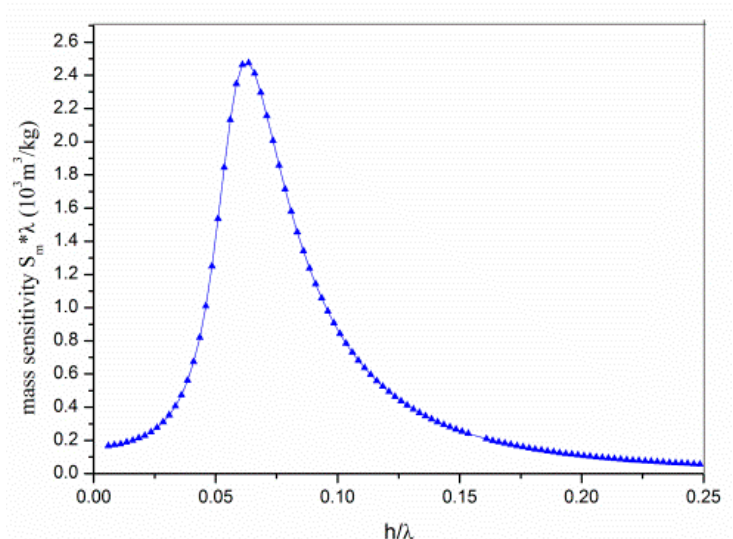
Figure 2. Simulation results for sensitivity vs. thickness of overlayer (polymethylmethacrylate (PMMA)). h is the thickness of waveguide and λ is the wavelength at the center frequency of delay